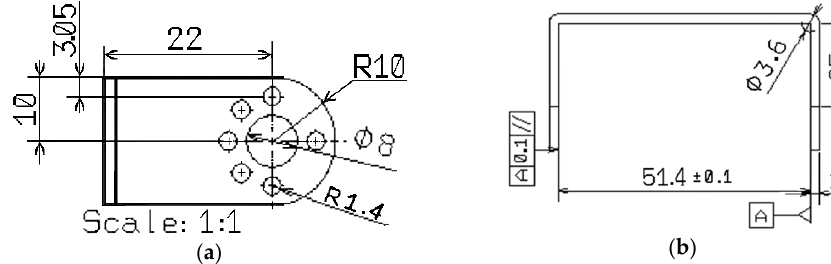
Figure 3. CAD virtual model of servo bracket to present and define the geometric parameters: ( a ) 2D drawing in the front view of the bracket; ( b ) bottom view of the servo bracket for the robotic arm.